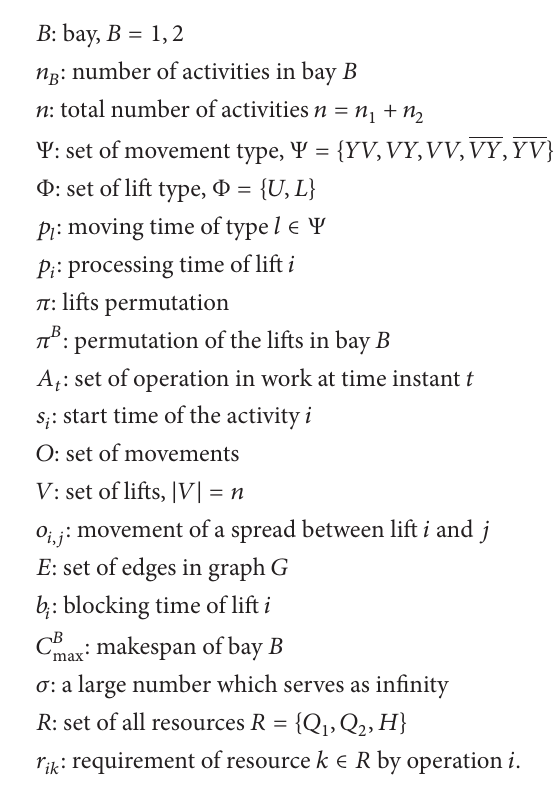
Table 1: Four modes of movement combination. 𝑜 𝑖 Movements Lift 𝑗 𝑖𝑗 Lift 𝑂 1 U {𝑉𝑌, 𝑌𝑉} U 𝑂 2 L {𝑉𝑌,𝑌𝑉} L U {𝑉𝑌,